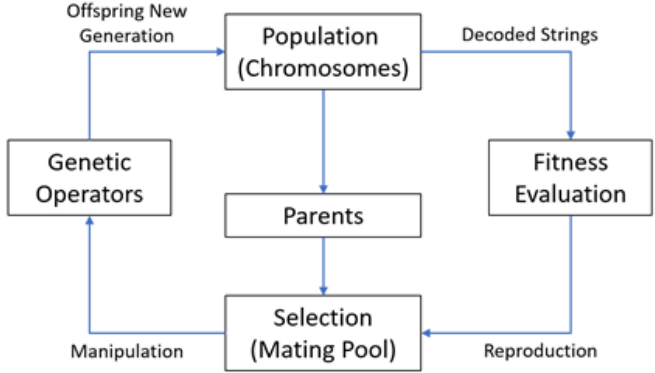
Figure 7. Flowchart of the GA cycle.